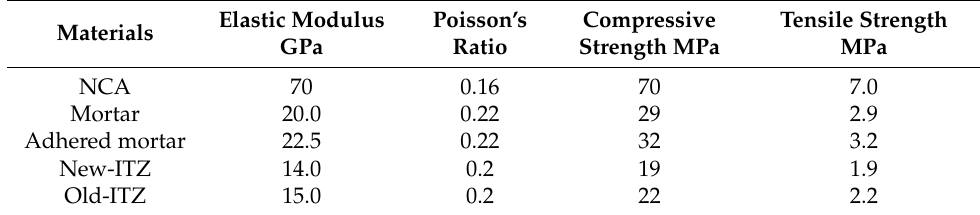
Table 4. Meso-material parameters of RAC.